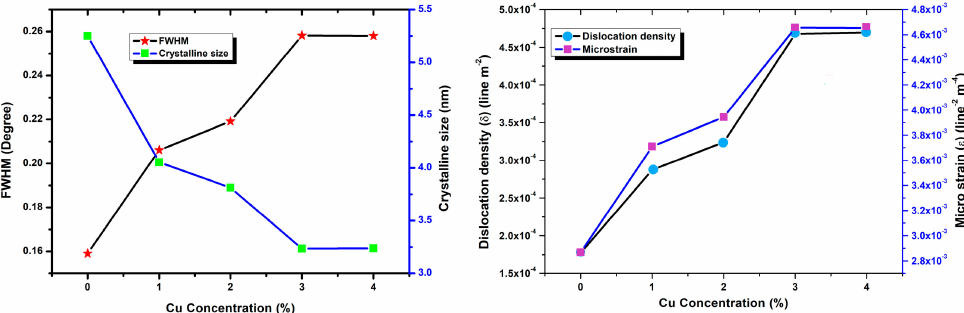
Figure 5. ( left ) Peaks full width at half maximum (FWHM) and crystalline size as a function of the dopants concentration; ( right ) dislocation density and microstrain as a function of dopants